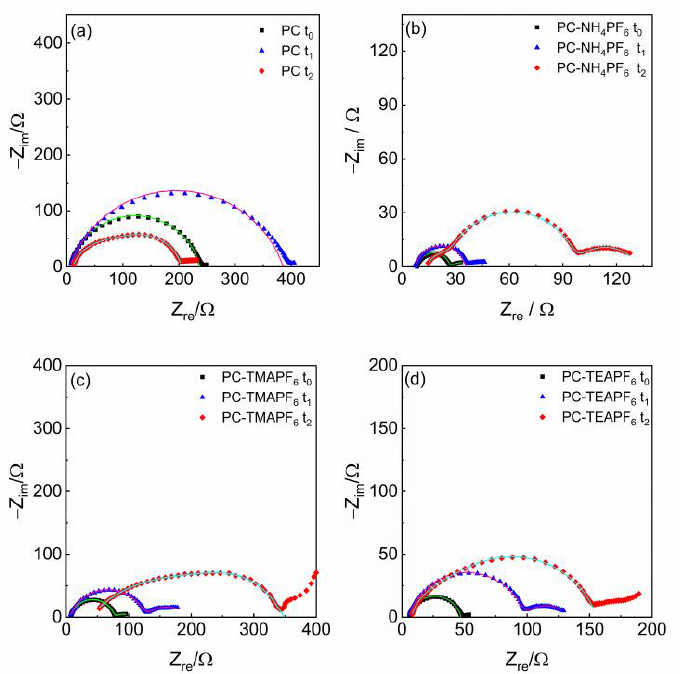
Figure 6. Electrochemical impedance spectra of Li||Li symmetric cells ( a ) PC, ( b ) PC-NH 4 PF 6 , ( c ) PC-TMAPF 6 , ( d ) PC-TEAPF 6 after different cycling time. The green, red and cyan lines in the figures are the fitting results for the t 0 , t 1 and t 2 plots, respectively. The plot at t 2 in Figure 6c has been recorded at the end of the test reported in Figure 4c (after 945 total cycles).